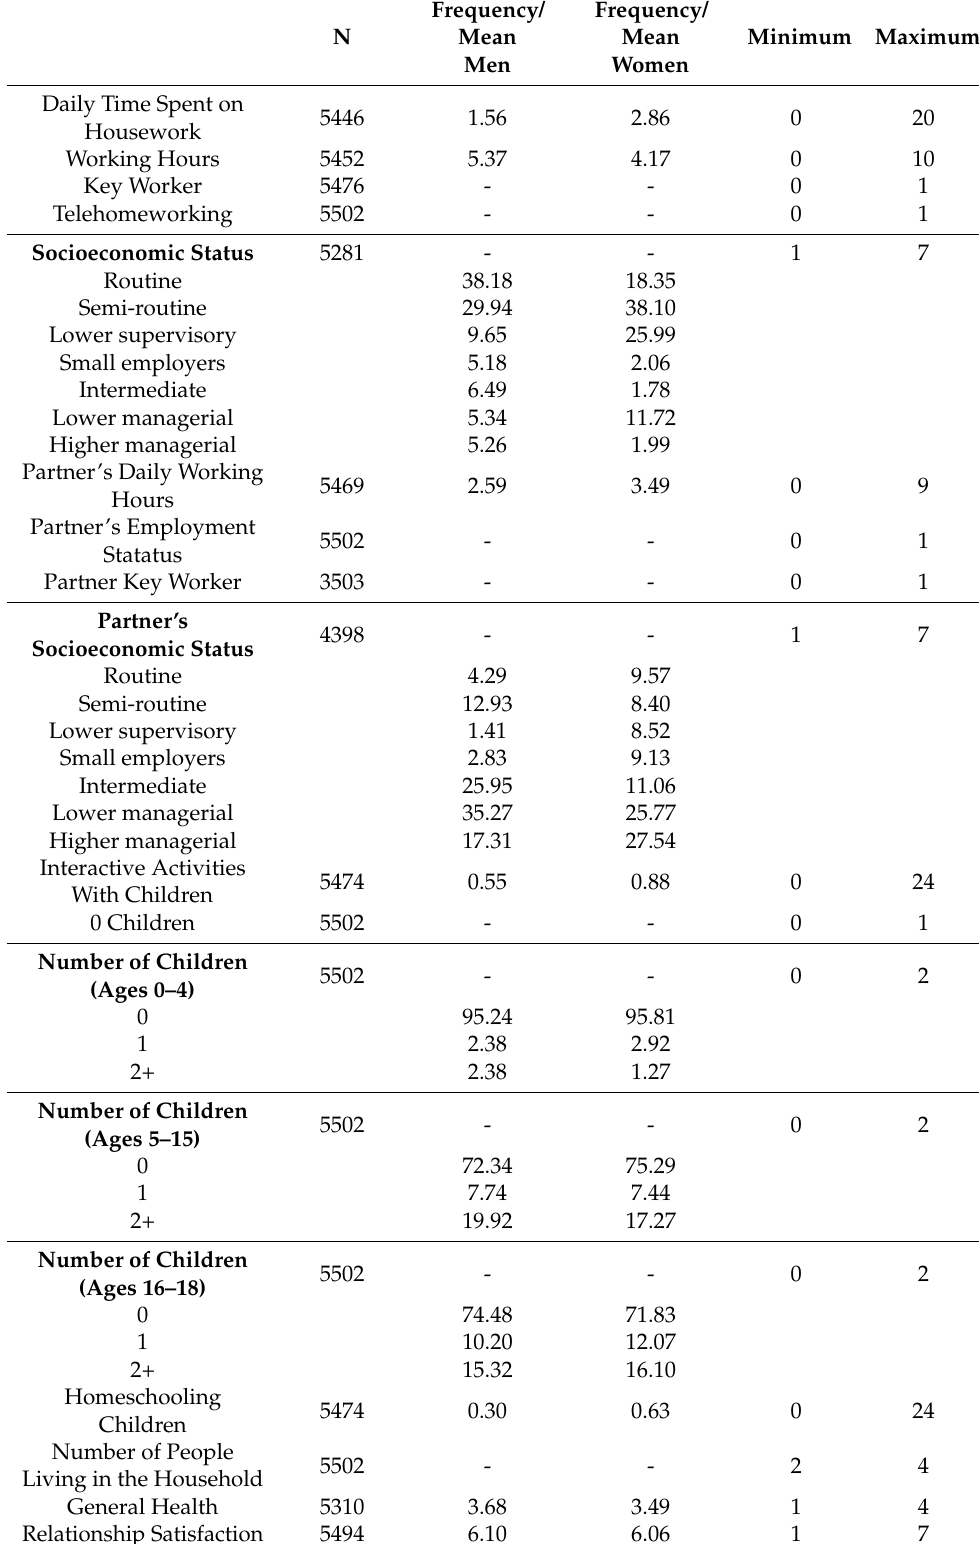
Table 1. Summary Statistics of